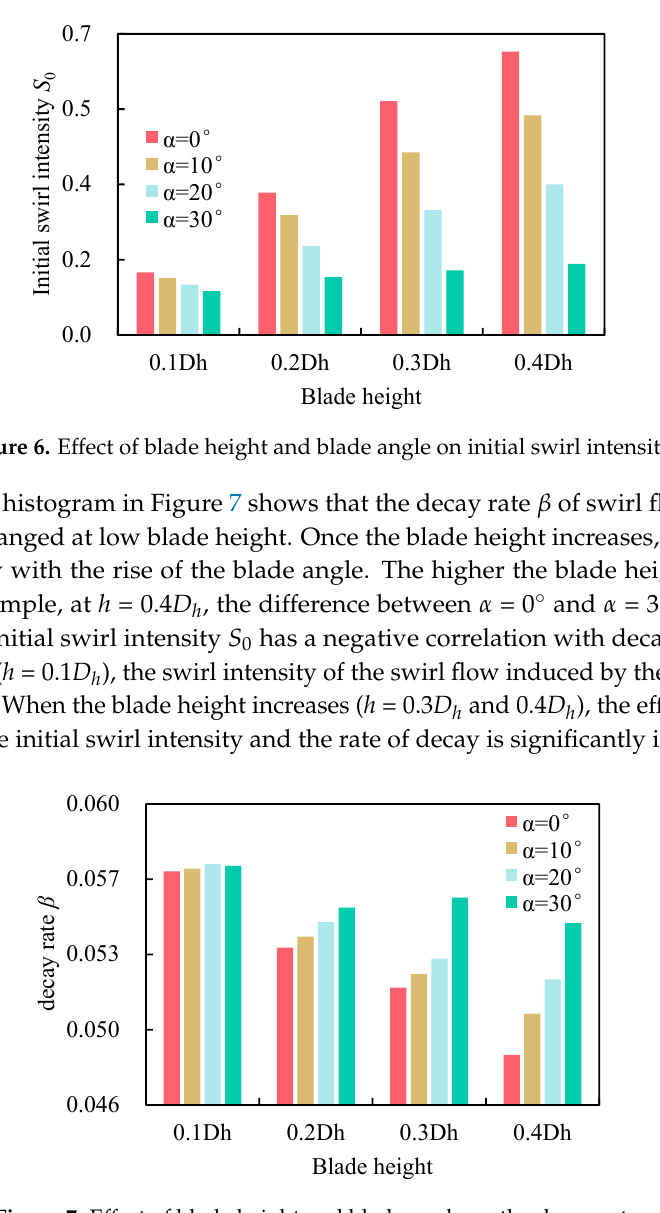
Figure 7. Effect of blade height and blade angle on the decay rate.